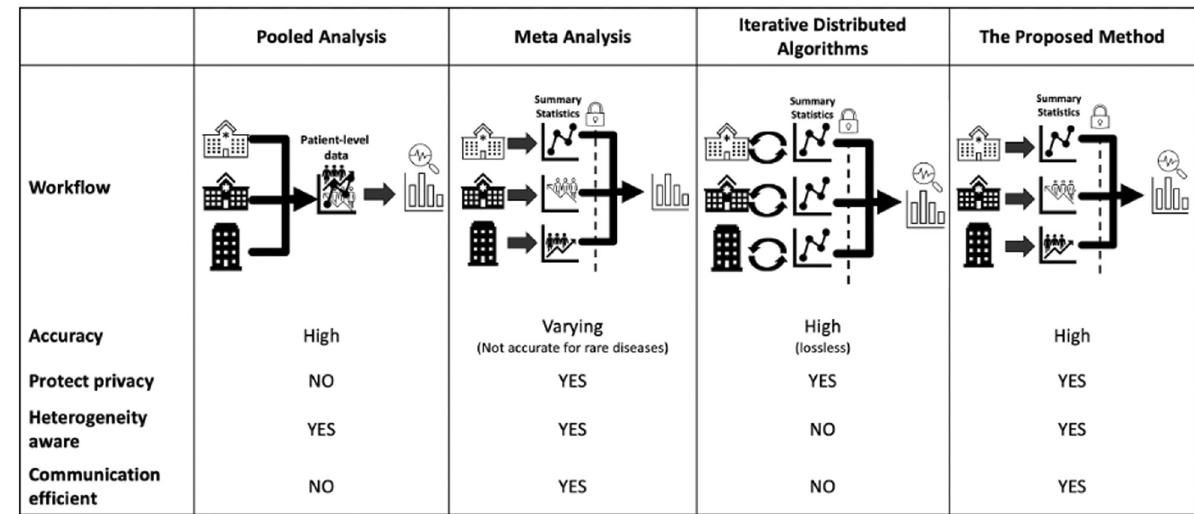
Fig. 2 Existing methods comparison. Comparisons between pooled analysis, meta-analysis, iterative distributed algorithms, and the proposed method. The proposed method can retain high accuracy when estimating association between exposures and outcome of interest. In addition, the proposed method can handle heterogeneity across the sites and protect patient privacy with ef fi cient